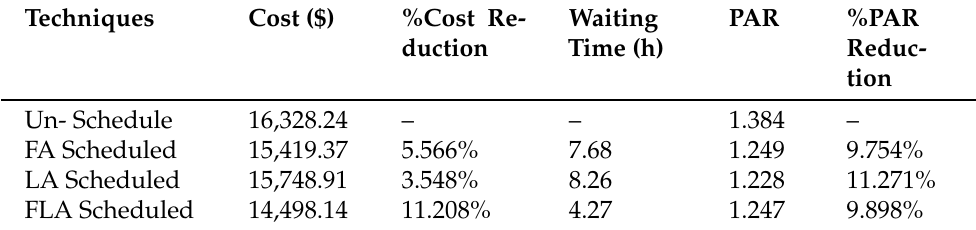
Table 4. Comparison of FLA with unscheduled load and the load scheduled with FA and LA